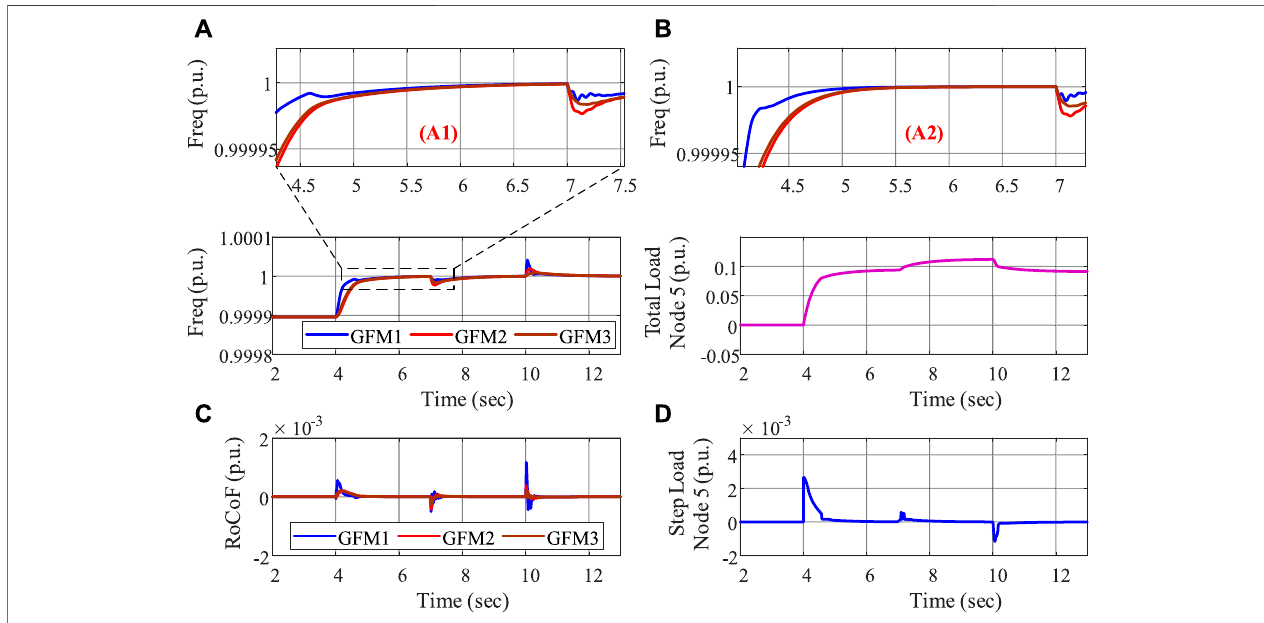
FIGURE 5 | Load ramping rate constraint evaluation: (A) frequency, (B) total load decrease, (C) RoCoF, and (D) load ramping.